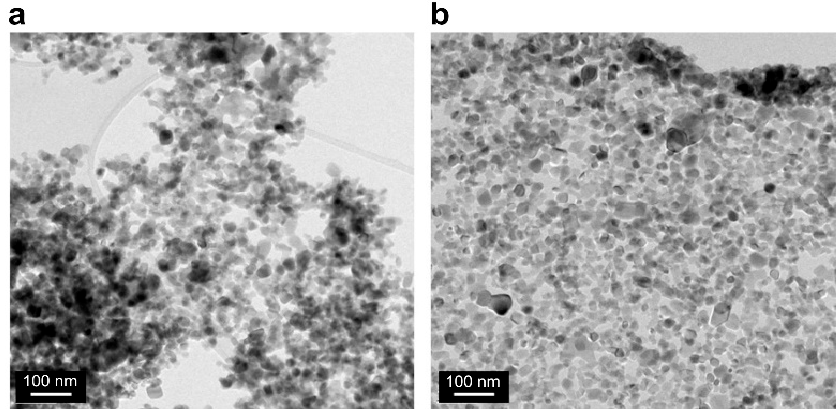
Figure 7. TEM images before ( a ) and after ( b ) ultrasonic dispersion.